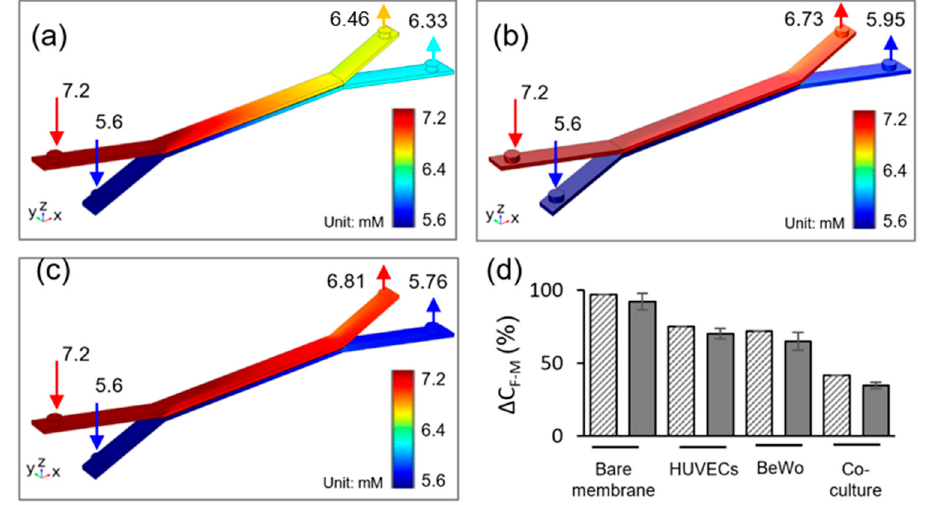
Figure 3. Glucose concentration profiles at flow rate of 50 µL/h in ( a ) bare membrane, ( b ) trophoblast monoculture, ( c ) trophoblast/HUVEC co-culture. ( d ) Comparison between experimental data and numerical simulation of glucose diffusion rate, Δ CF-M across the maternal-fetal interface for 2 h experiment time, under the 50 µL/h flow rate. Gray solid fill—experimental data, pattern fill— numerical simulation.